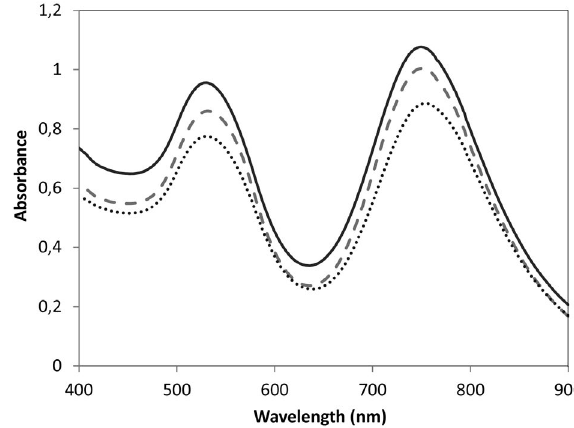
Figure 3. Changes in the SPR bands of GNRs after modification with PSS. From top to bottom: control GNRs, GNRs-PSS (1.5 μM), and GNRs-PSS (5 μM).